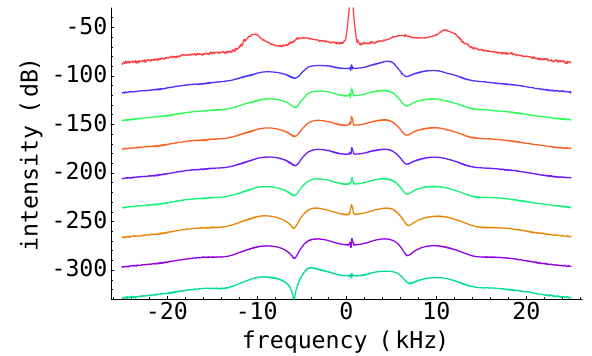
FIG. 5. (Color) Measured beam response functions of a 200 mA nine-bunch fully stretched beam about nine successive revolution harmonics in the NSLS VUV ring. The top trace is about the 54th revolution harmonic (sixth bunch harmonic) and lower traces are successive revolution lines. Machine parameters are given in Table